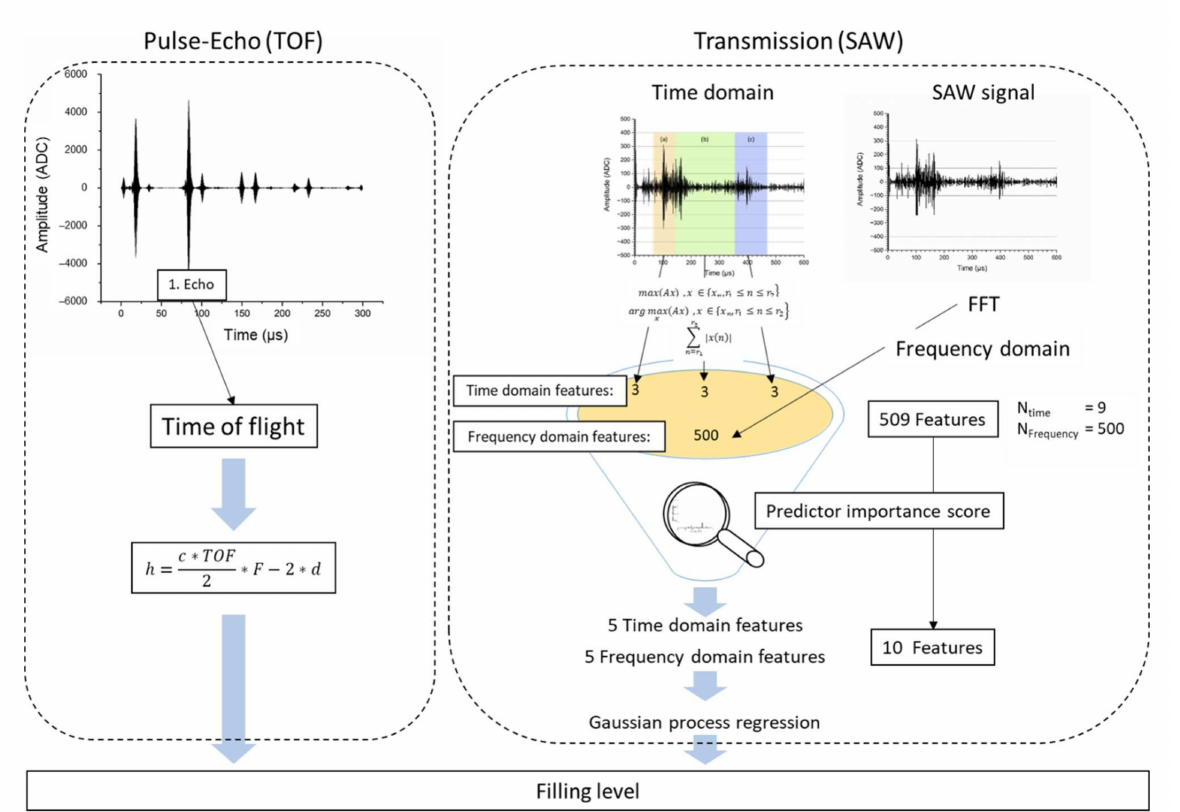
Figure 5. Signal processing strategy for model based pulse-echo (TOF) analysis ( left ) and transmission (SAW) analysis ( right ) using a data driven model. Both methods are calculated seperately and estimate the filling